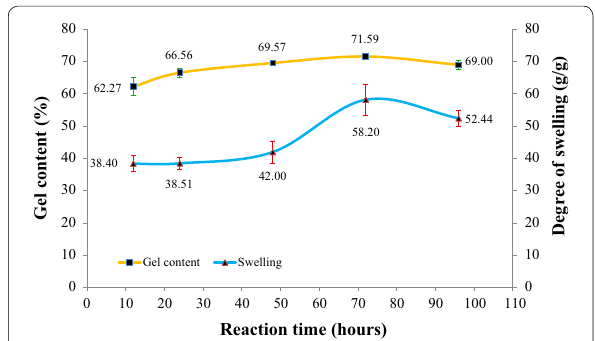
Fig. 5 Effect of time of reaction on gel content and degree of swelling of CMSS–acid